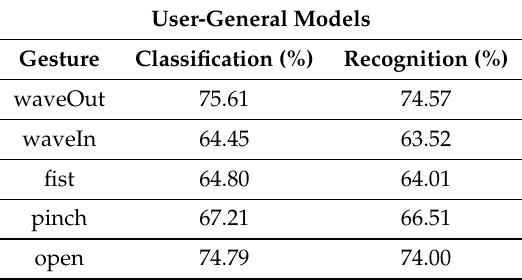
Table A1. HGR general model tests for different synchronization gesture.